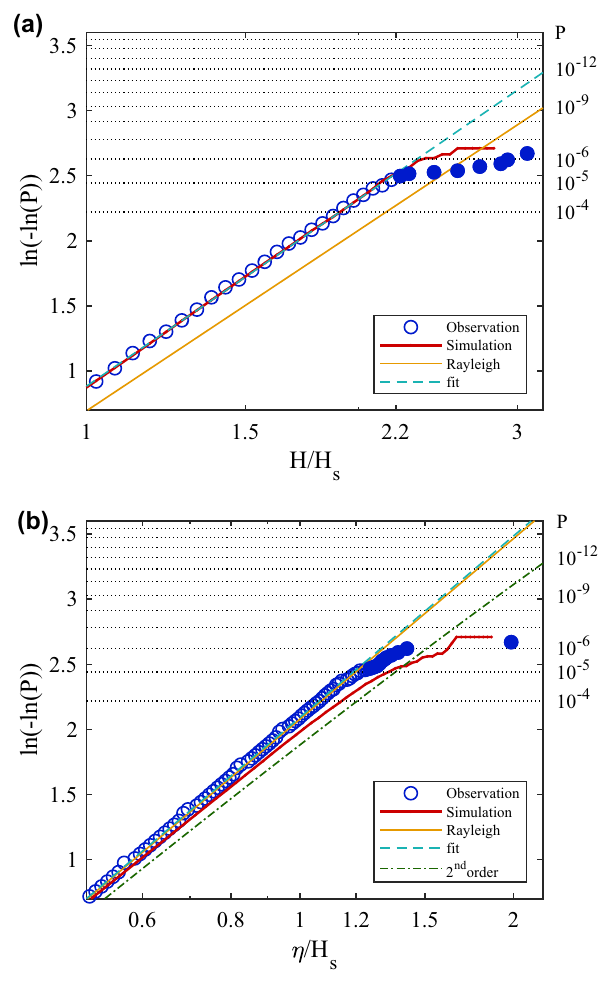
Figure 2. Exceedance probability P of ( a ) non-dimensional wave height H / H s , and ( b ) non-dimensional crest height η/ H s . Second order curve is based on steepness R